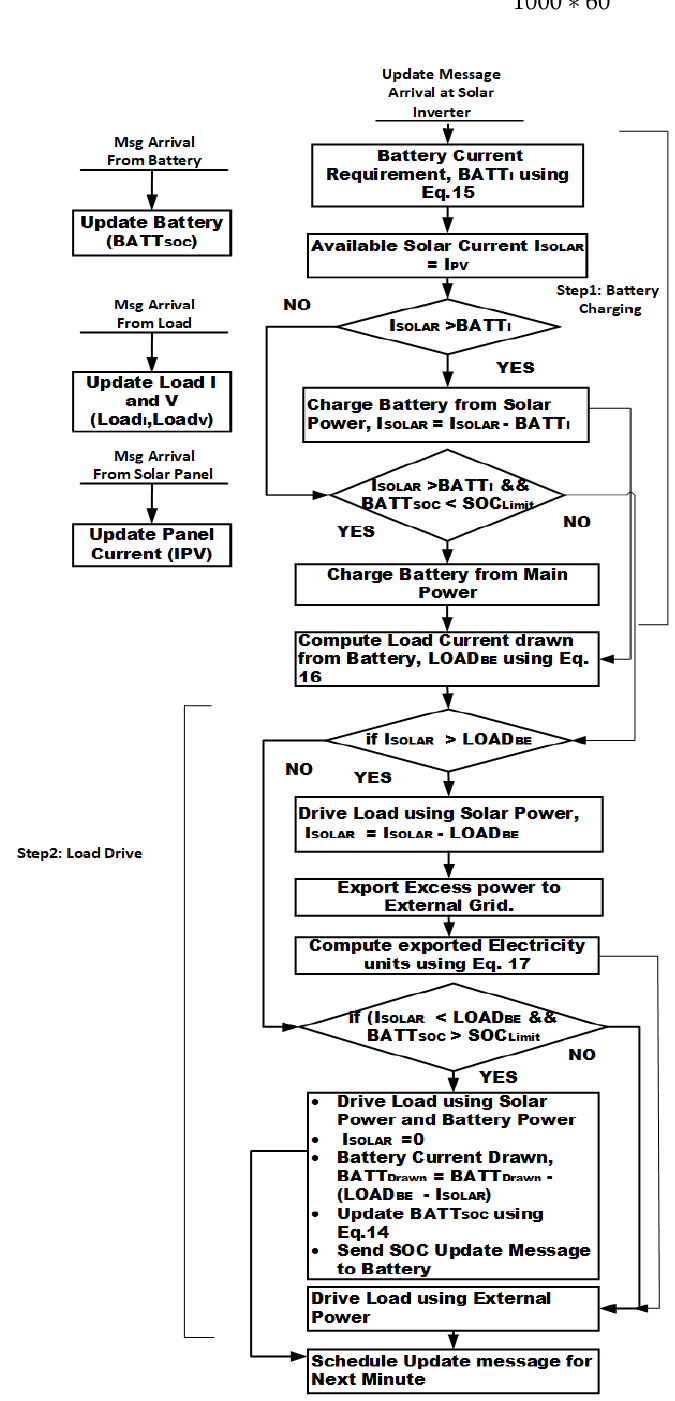
Figure 7. Working process of grid-tied solar inverter node.